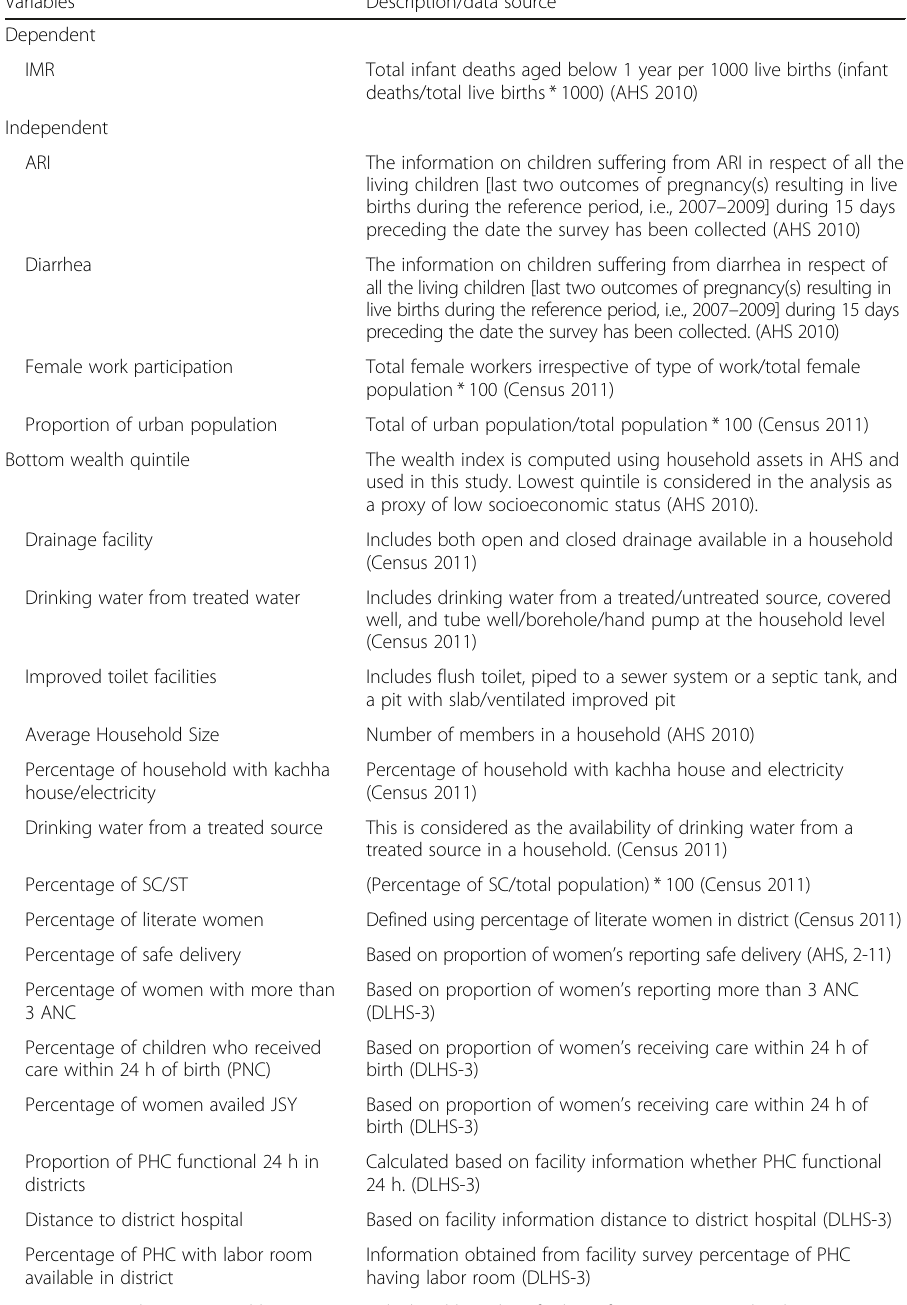
Table 1 Exposure variables used in spatial modeling the infant mortality in nine high-focus states in India, AHS (2010 – 2011) and DLHS-3 (2007 –